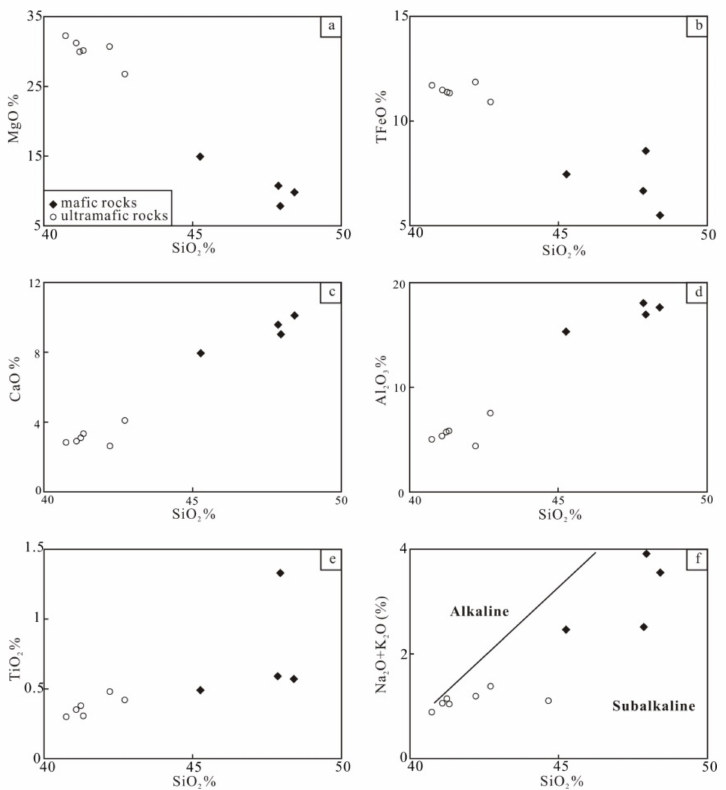
Figure 8. Harker diagrams ( a – e ) and alkaline-silica diagram ( f ) for the mafic-ultramafic rocks of the Baixintan intrusion (after